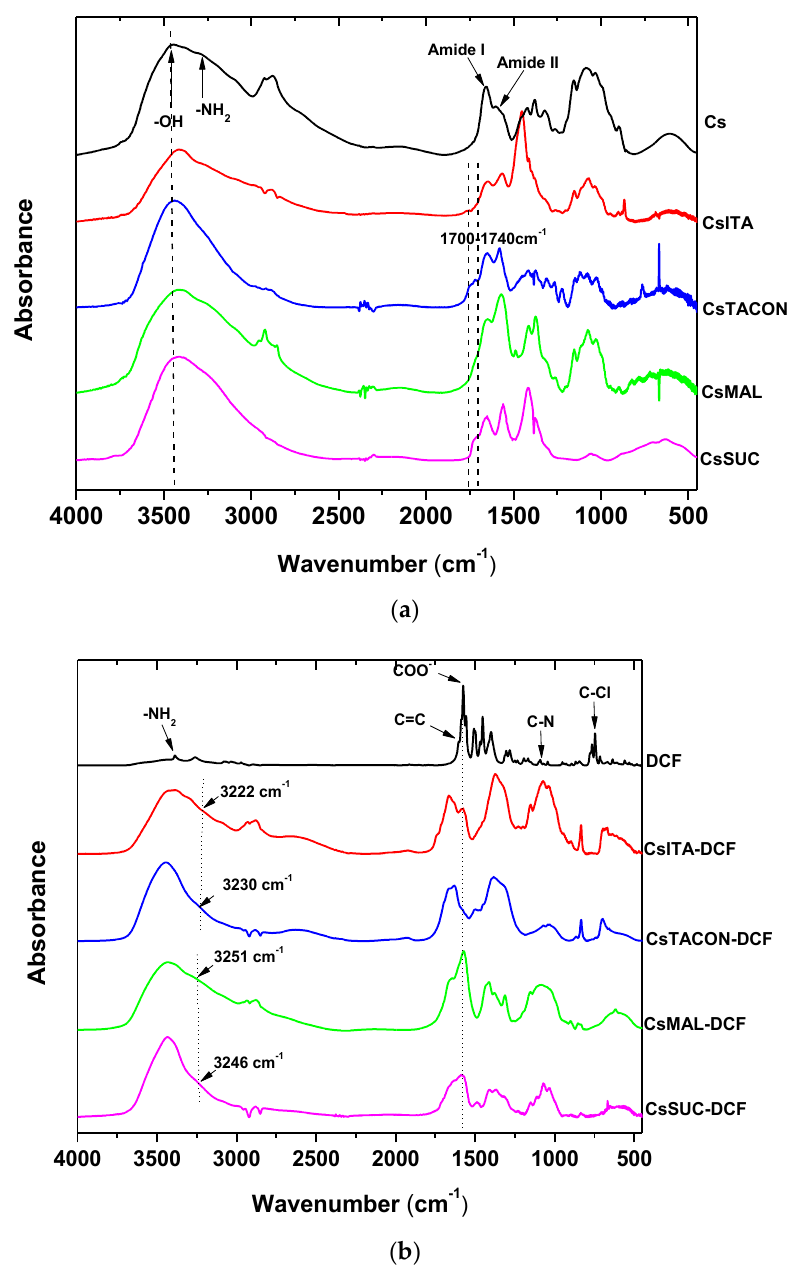
Figure 13. FTIR spectra of the synthesized chitosan derivatives: ( a ) before cross-linking in comparison with neat CS; ( b ) after cross-linking and DCF adsorption [17].